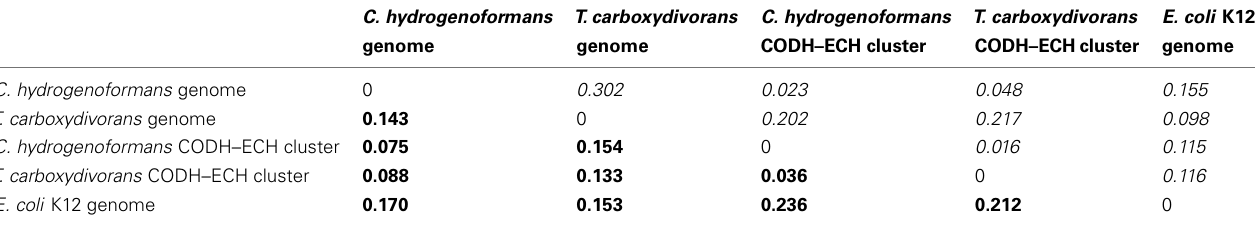
Table 1 | Kullback–Leibler divergence comparing codon usage (bold) and tetranucleotide frequency (Italics) for various combinations of the C. hydrogenoformans , T. carboxydivorans , and E. coli K12 genomes and the C. hydrogenoformans and T. carboxydivorans CODH-ECH gene